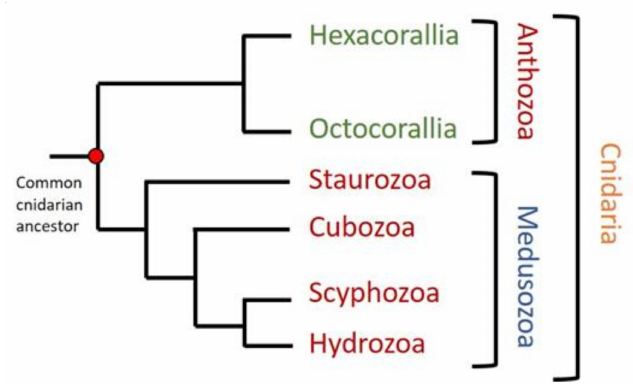
Figure 1. Phylogenetic tree of cnidaria phylum. Two di ff erent groups can be distinguished in cnidaria: Anthozoa, containing Hexacorallia and Octocorallia subclasses, and Medusozoa, including Staurozoa, Cubozoa, Scyphozoa, and Hydrozoa. Figure modified from